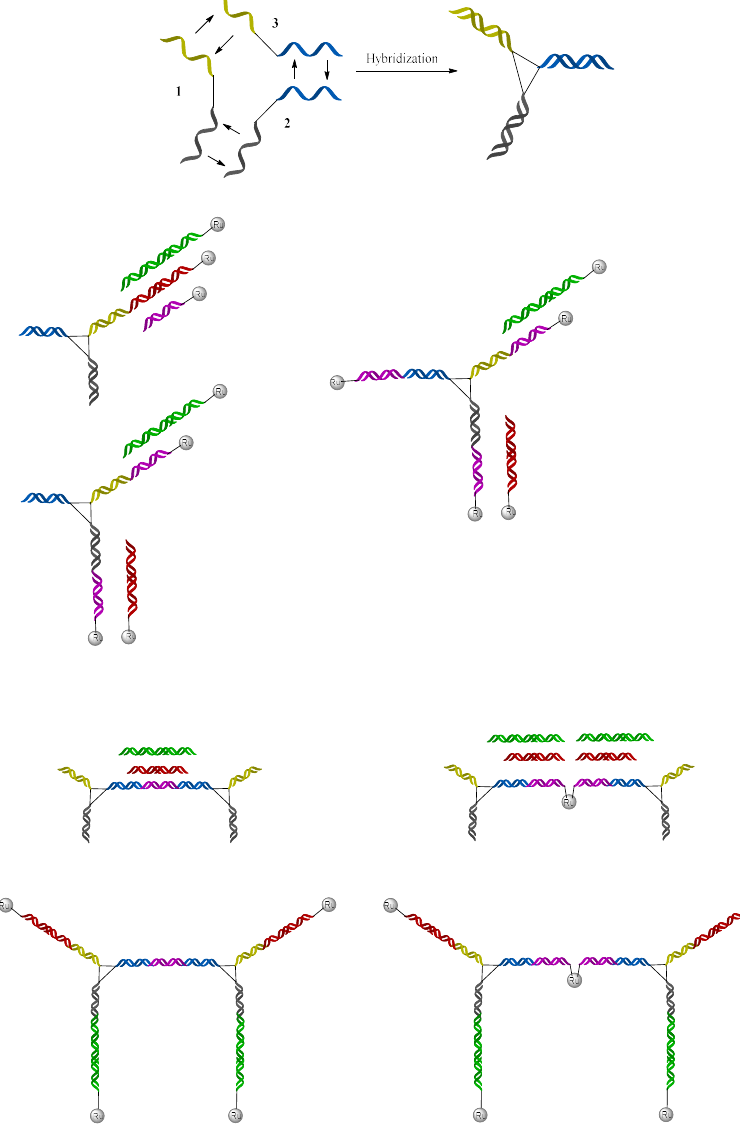
Figure 13. Synthesis of the three-way junction by hybridization of DNA sequences 1 , 2 , and 3 (black lines represent the dodecyl linkers) and structures of three-way DNA junctions with mono Ru-DNA and double-star assemblies